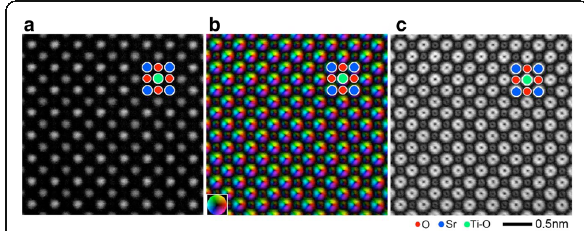
Fig. 6 Simultaneously acquired atomic-resolution STEM images of SrTiO 3 [001]. a ADF STEM image. b Projected electric field vector color map (left side) and electric field strength map (right side) constructed from the segmented-detector STEM images. The inset color wheel indicates how color and shade denote the electric field orientation and strength in the vector color map. It is seen that both heavy and light element columns are sensitively imaged. Intensity dips are clearly visible at the center of each atomic column position. Images taken with a JEOL ARM-300CF operating at 300 kV, adapted from Shibata et al.